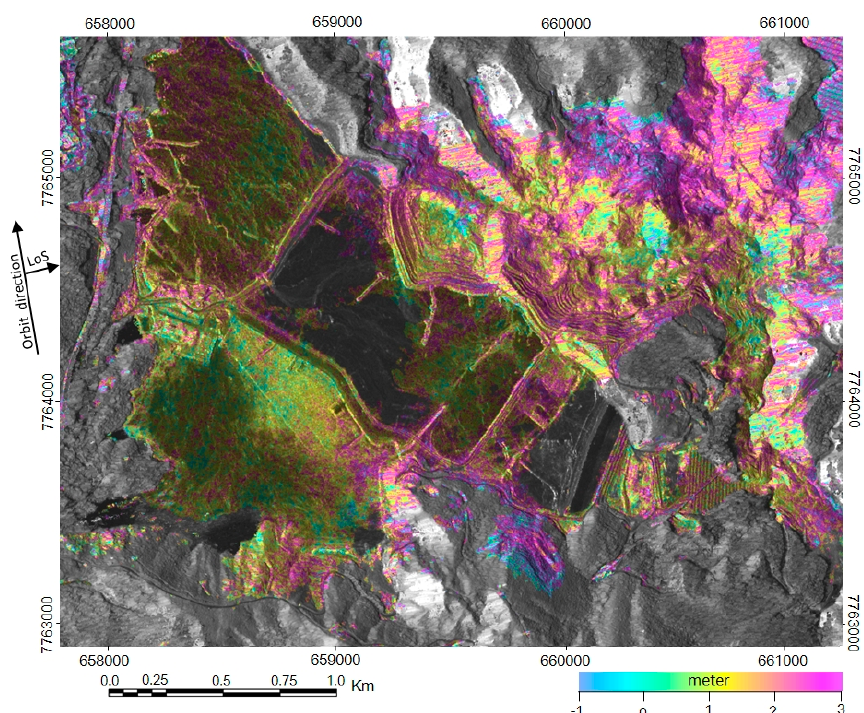
Figure 7. Digital elevation error derived from SBAS analysis.